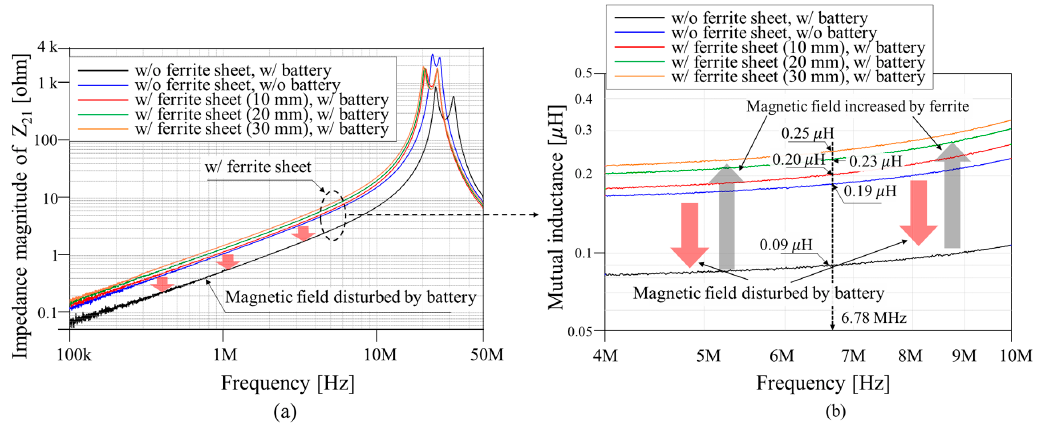
Figure 13. Measured Z 21 of the transmitting coil and receiving coil, with various thicknesses of ferrite under the receiving coil. ( a ) Impedance magnitudes between transmitting coil and receiving coil (Z 21 ) under the various ferrite sheet condition. ( b ) Calculated mutual inductances @6.78MHz by using Z 21 parameters.